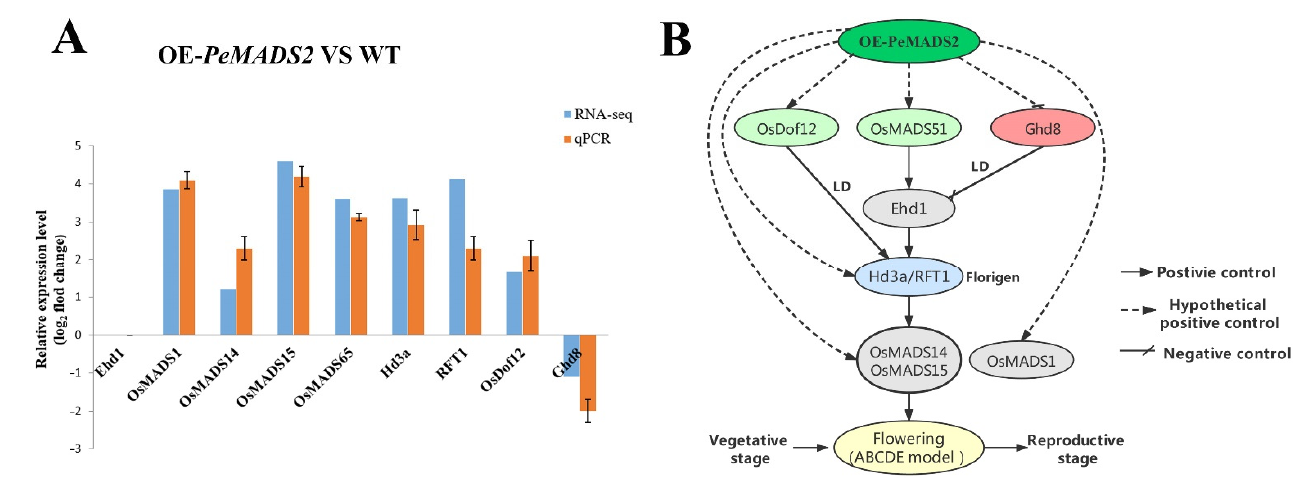
Figure 7. Proposed working models of OE- PeMADS2 to induce the early flowering in transgenic rice. ( A ) Relative expression pattern analysis of rice floral-related genes by qRT–PCR analysis to validate RNA-seq data. Rice Ubq or EP were used as reference genes; mean ± SD of three biological replicates is presented. ( B ) The model of the early flowering signal pathway in OE- PeMADS2 transgenic rice. Arrows with solid lines indicate positive regulators of flowering, arrows with lines indicate negative regulators of flowering, and arrows with dotted lines indicate hypothetical positive control of flowering. Table 1. DEGs related to rice floral pathway in transgenic plants.